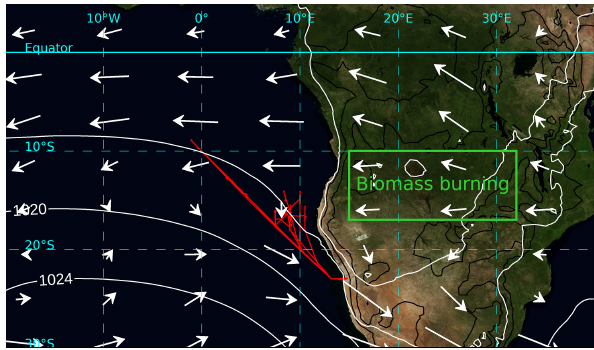
Figure 1. Selected flight tracks (red lines) of the NASA P-3B Orion aircraft during the ORACLES 2016 IOP used in this study, with corresponding flight dates listed in Table 1. The map is the NASA new blue marble, a true-color Earth image from Stockli et al. (2011), ©NASA. Superimposed on the map are the September 2016 monthly mean 700hPa winds (white vectors) and surface pres- sure (white isobars), along with the approximate biomass burning region (green